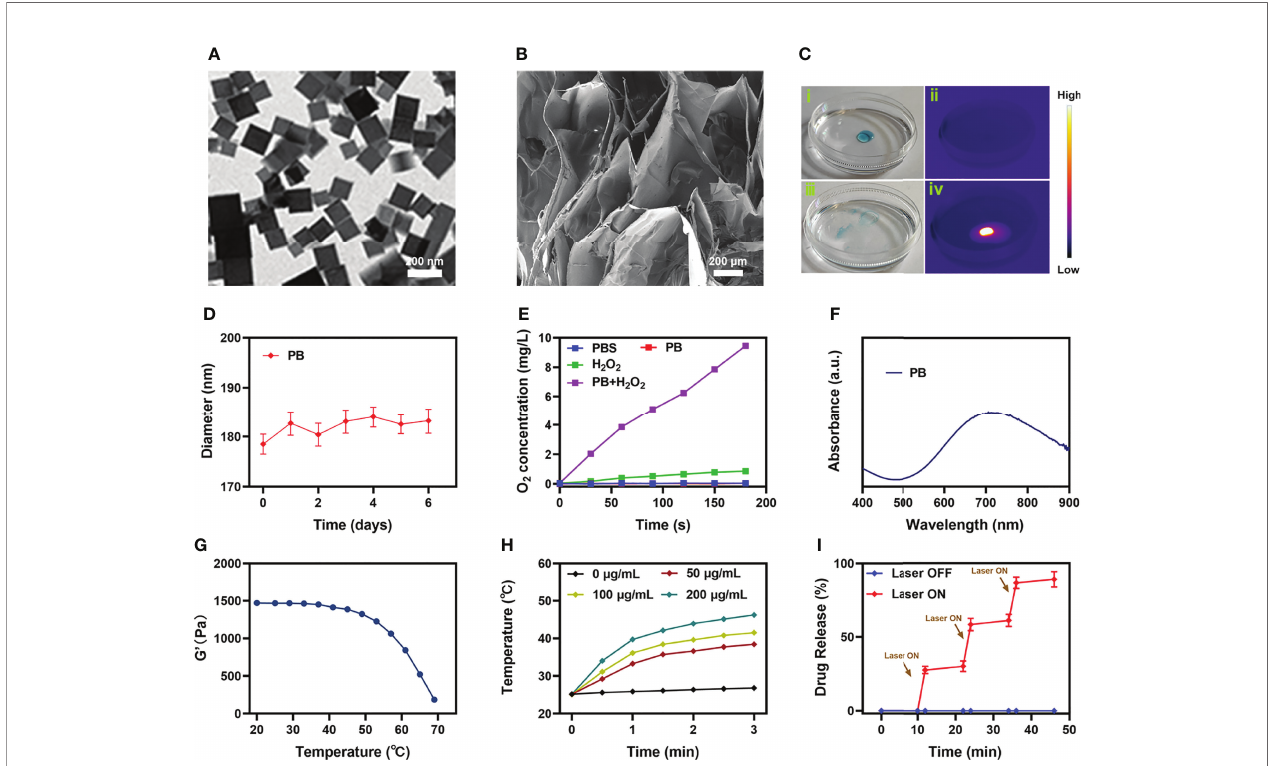
FIGURE 1 | Characterization analysis of PB+Ce6@Hy. (A) TEM image of PB. (B) SEM image of agarose hydrogel. (C) The morphology of the prepared PB+Ce6@Hy before (i) and after (iii) 0.5 W/cm 2 808 nm laser irradiation for 10 min and infrared thermal images (ii, iv) of the prepared PB+Ce6@Hy following irradiation. (D) Hydrodynamic diameter of PB at different time points. (E) Oxygen generation in different conditions as measured by a dissolved oxygen meter. (F) UV – vis – NIR absorbance spectra of PB. (G) Rheological curves of agarose hydrogel. (H) Temperature elevation curves with the different concentration of PB at 808 nm laser irradiation. (I) In vitro Ce6 release pro fi le in the presence and absence of 808 nm laser irradiation, with arrows being used to indicate irradiation time